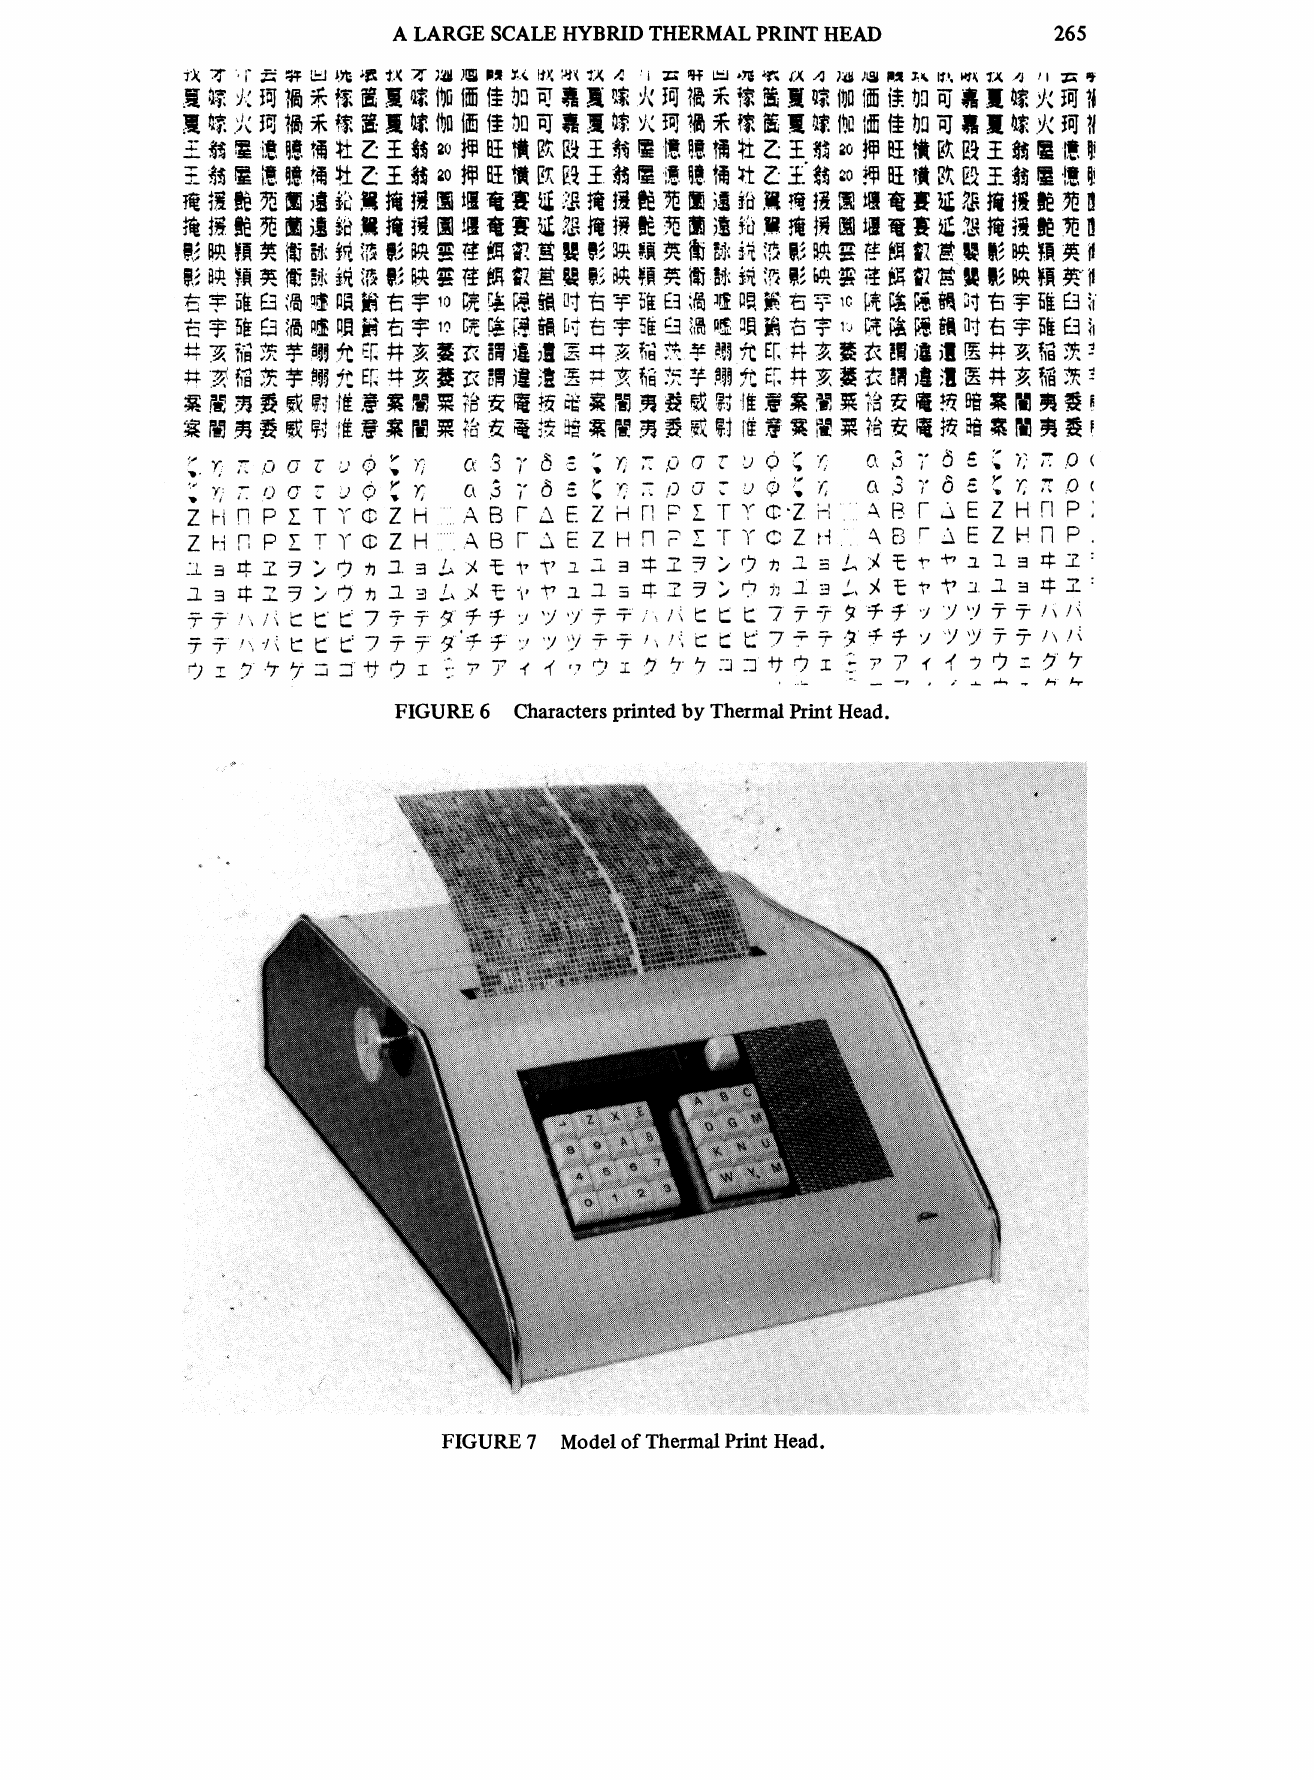
FIGURE 6 Characters printed by Thermal Print Head.